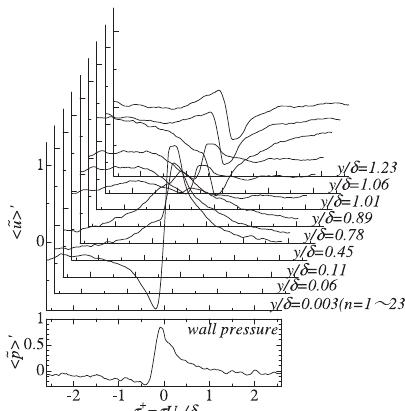
Fig. 11 Ensemble-averaged time histories of conditionally sampled velocity and wall static pressure at lower modes ( n = 1 ∼ 3). The detection is based on the VITA